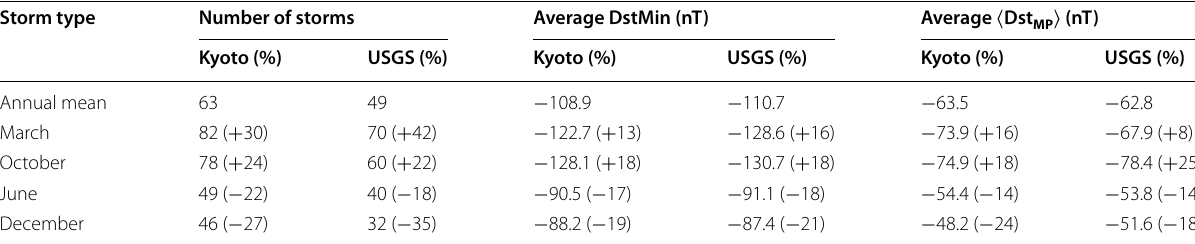
List of annual means, and equinoctial maxima and solstice minima of the number of storms, average DstMin and average ⟨ Dst MP ⟩ and their percentage deviations (in brackets) from the annual means in Kyoto Dst and USGS Dst by considering all storms in 1958–2007